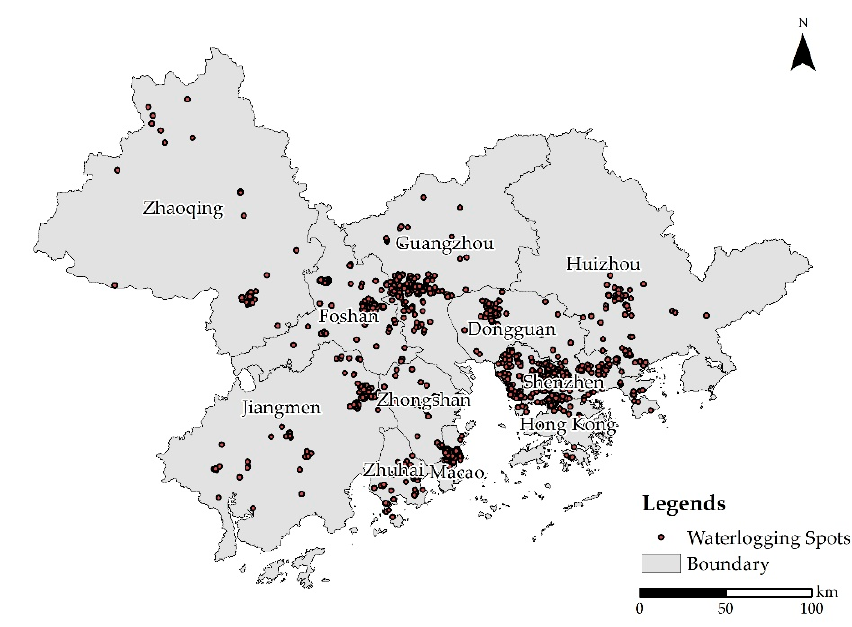
Figure 2. Rainstorm waterlogging inventory map of the